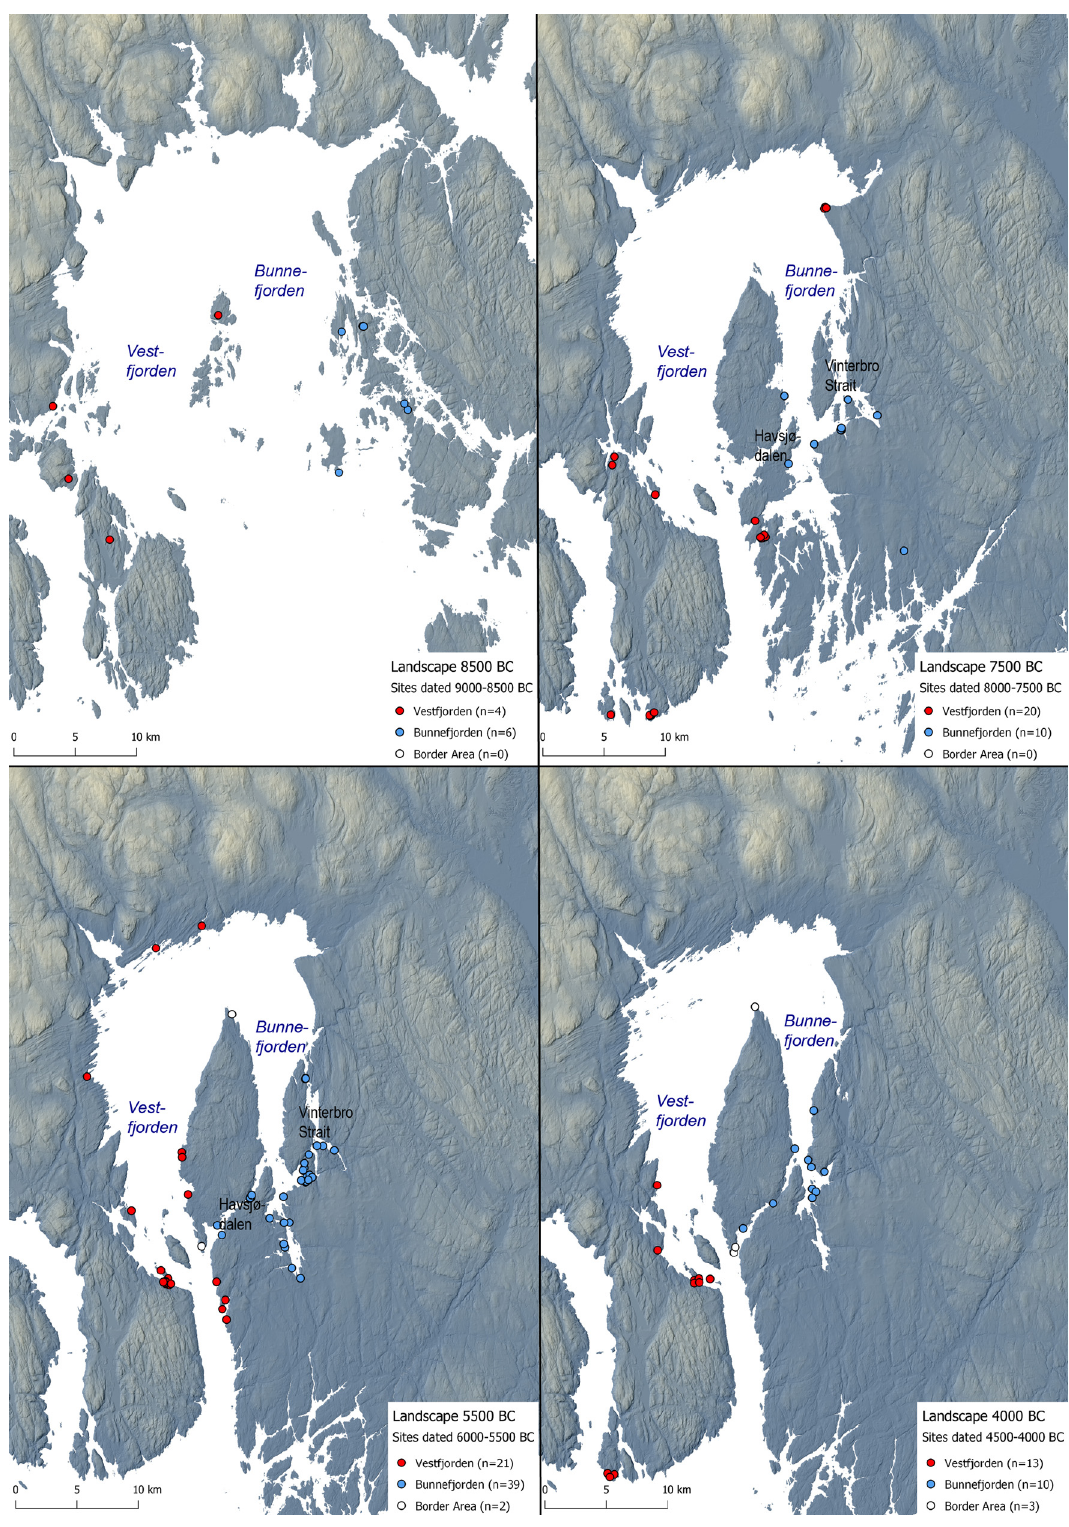
Figure 4: In the Boreal period ( c. 8250 – 7000 cal BC ) , the area under study went from being an archipelago landscape to a more closed, sheltered fjord system. By c . 8000 cal BC, the sea had withdrawn to approximately 115 m above the present level, and two straits slowly appeared. Around 7500 cal BC the shore level was 90 m above the present, and the strait of Havsjødalen linked Bunnefjorden and Vestfjorden. The two straits existed for 2500 years but decreased in width and depth as the land rebounded. Around 5400 cal BC, a process started whereby the Vinterbro sound, with the nearby locus Nøstvet, became dry land, and by c . 5000 cal BC the Havsjødalen sound closed. These events removed the two straits, and from c . 5000 cal BC Bunnefjorden became a more remote area in the innermost part of the Oslo Fjord. Illustration: Isak Roalkvam,